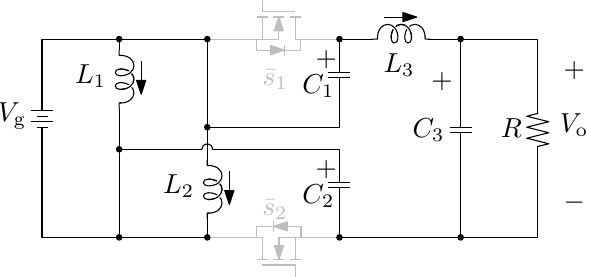
Figure 4. Equivalent circuit of switching state 1.